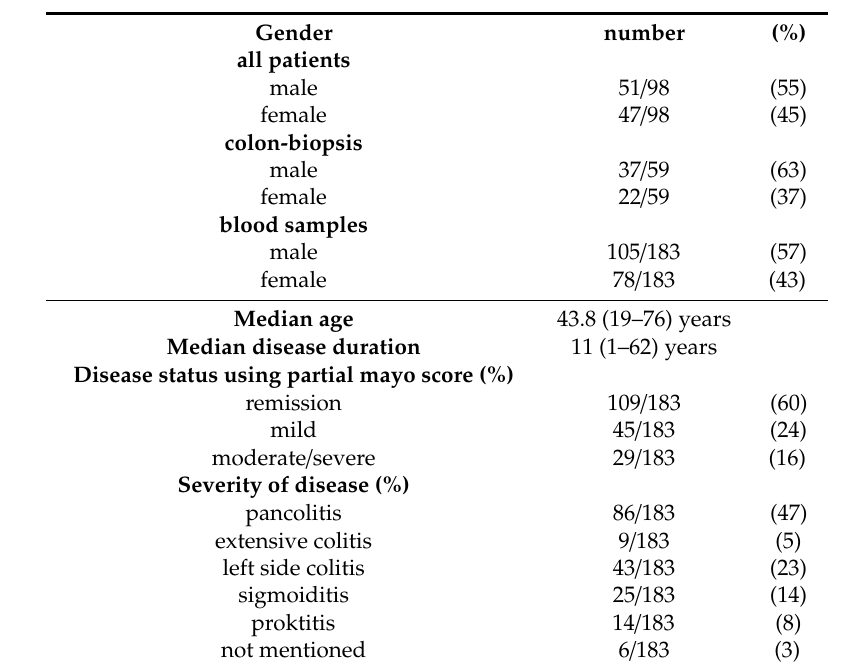
Table 2. Patient